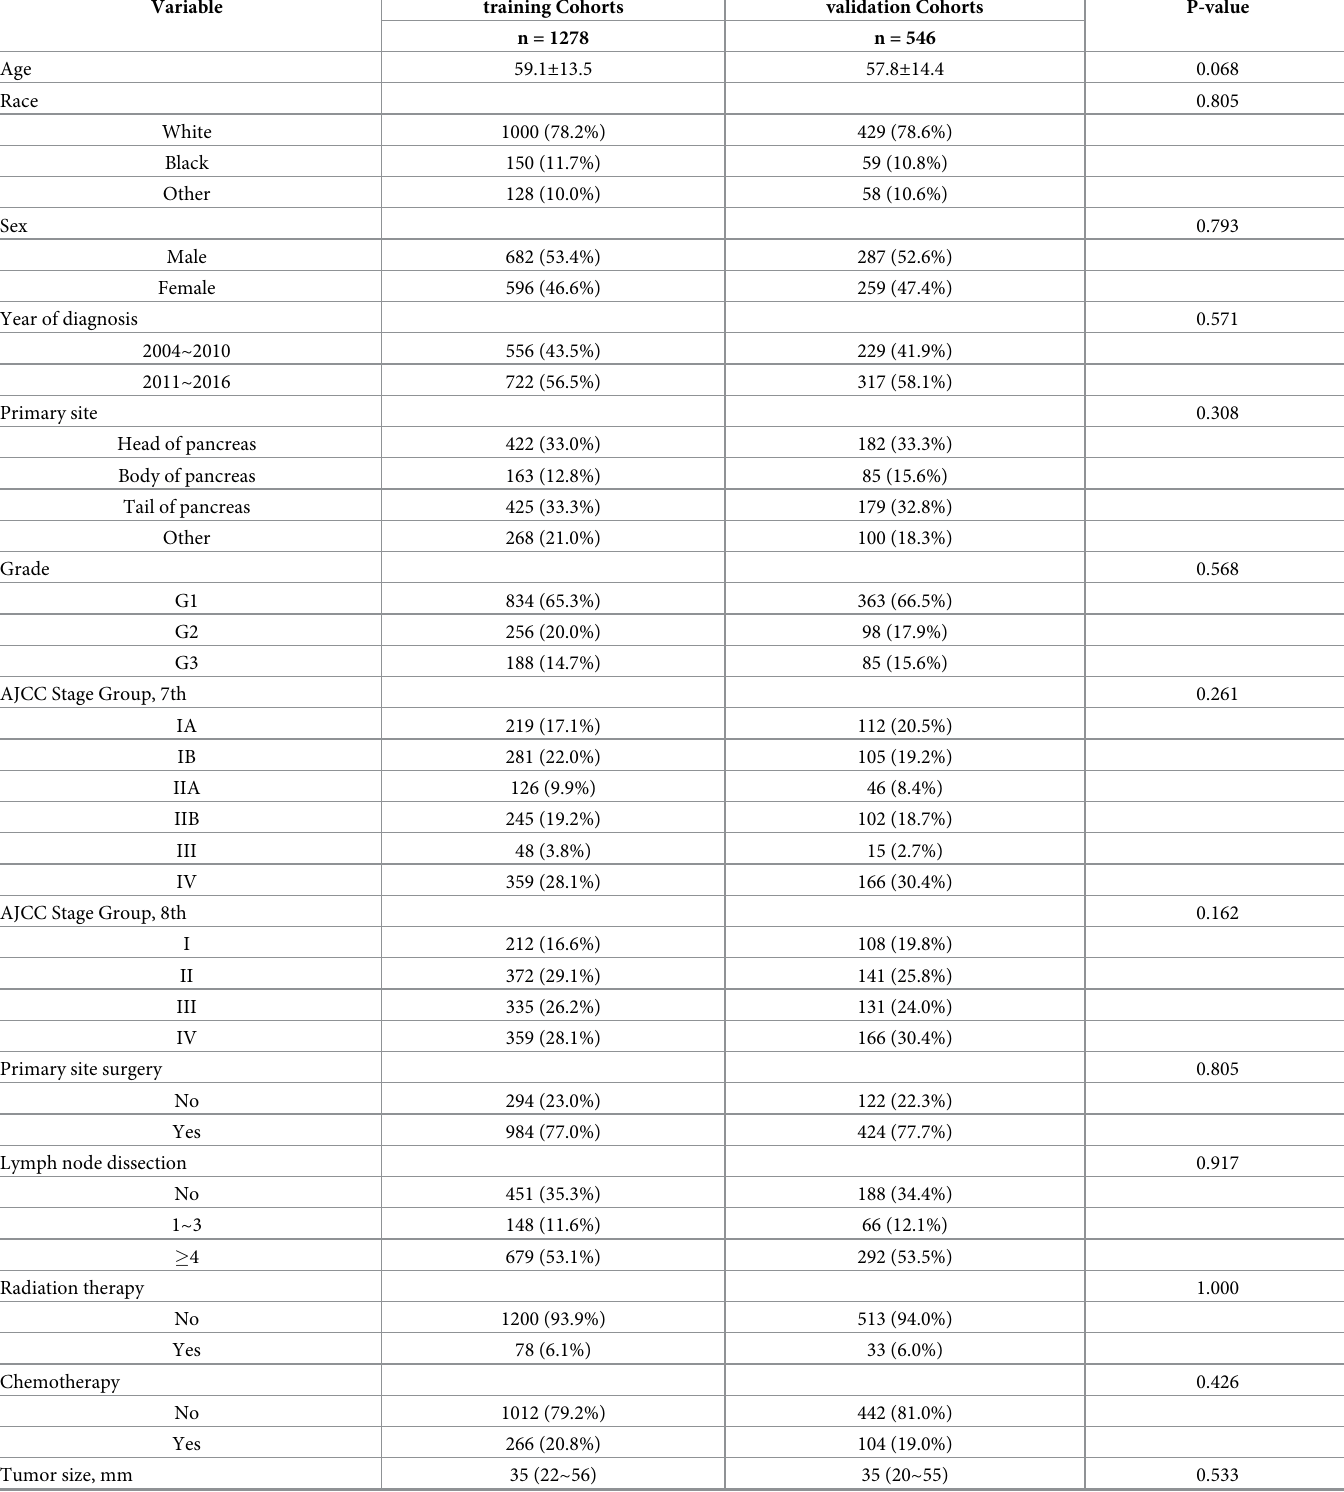
Table 1. The demographic and clinicopathological characteristics of the training and validation